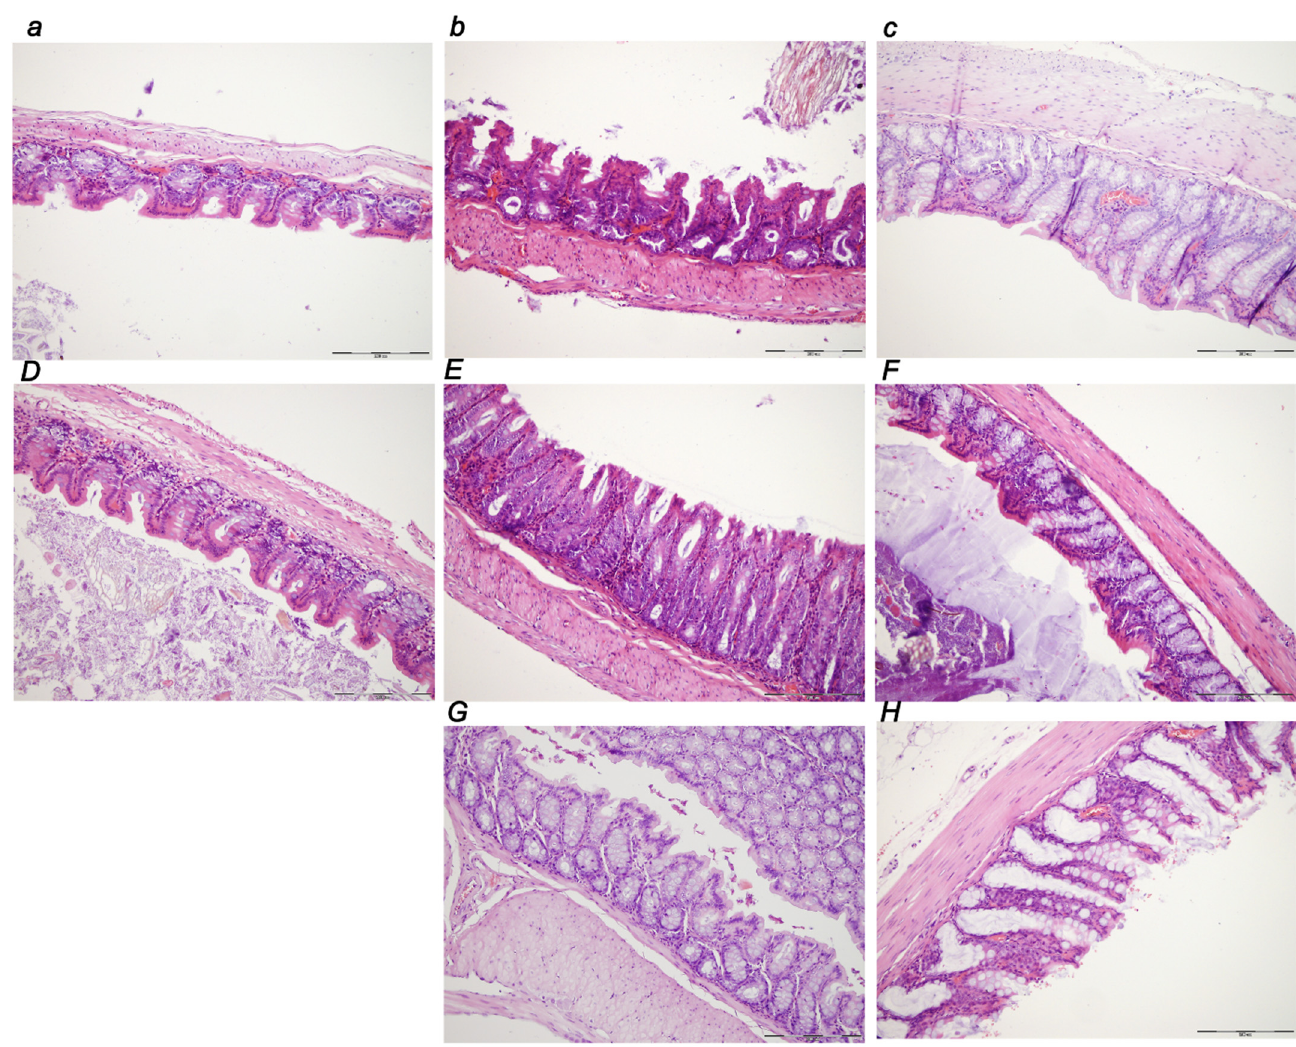
Figure 13. Large intestine damage illustrative microscopic presentation (HE staining; magnification 100×; scale bar 200 μ m) in rats with obstructed bile duct ( a – H ) at the end of the ligation time periods of 30 min, 5 h, and 24 h; as an early regimen at 0–30 min ( a , D ), 0–5 h ( b , E ), and 0–24 h ( c , F ) application sacrifice period; and as delayed regimen at 4.30 h–5 h ( G ) and 5 h–24 h ( H ) application sacrifice period in controls ( a – c ) and BPC 157-treated rats ( D – H ). In controls, marked congestion appeared at 30 min ( a ), 5 h ( b ), and 24 h ( c ) ligation time, more prominent at 24 h ( c ). In the BPC 157 early regimen ( D – F ), no changes appeared at 30 min ( D ), 5 h ( E ) and mild congestion at 24 h ( F ) ligation time. In the delayed regimen ( G , H ), there was no change at 4.30 h–5 h ( G ) and only mild congestion appeared at 5 h–24 h ( H ) application sacrifice period.